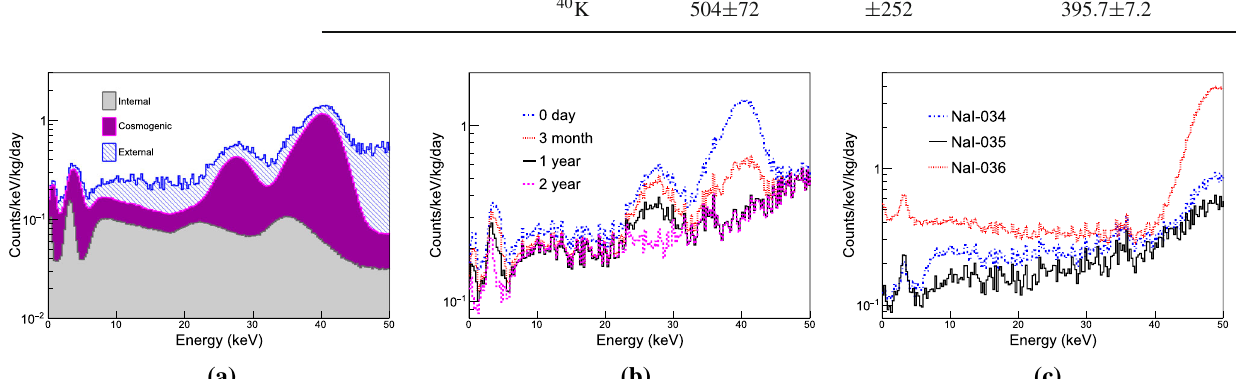
(red-dotted line), 1 year (purple-dashed line) , and 2 years (black-solid line). c The expected background spectra of the COSINE-200 detec- tors assuming background levels obtained from NaI-034 (blue-dashed- dotted line), NaI-035 (black-solid line), and NaI-036 (red-dotted line) after being underground for 2